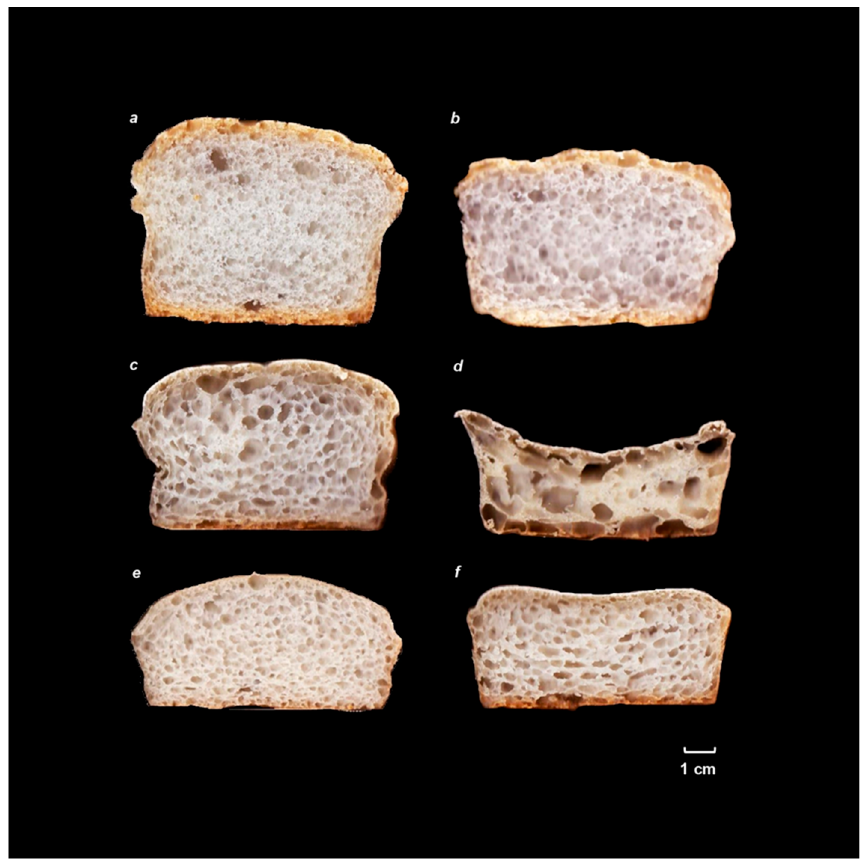
Figure 3. Images of gluten free breads. Control 1 ( a ); Control 2 ( b ); CF 1 ( c ); CF 2 ( d ); ACF 1 ( e ); ACF 2 ( f ).